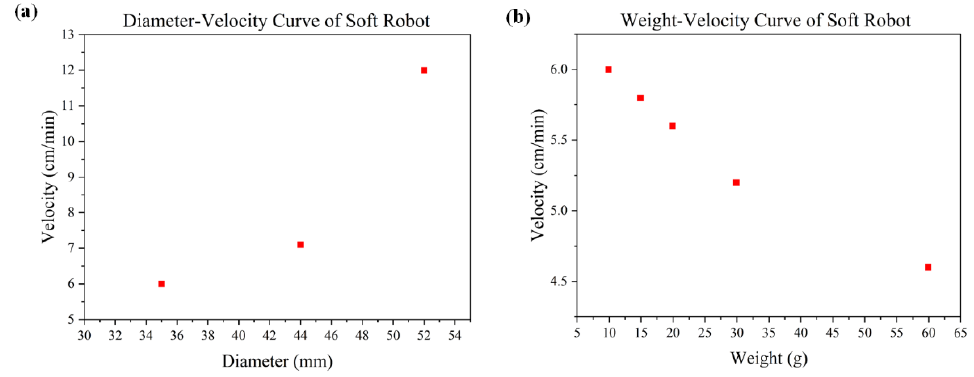
Figure 7. The moving speeds with different influencing factors. ( a ) Moving speeds when the diam- eters of the central axial actuator are set to 35 mm, 44 mm and 52 mm, respectively. ( b ) Moving speeds when the weight of the object to be extracted ranging from 9.9 g to 59.9